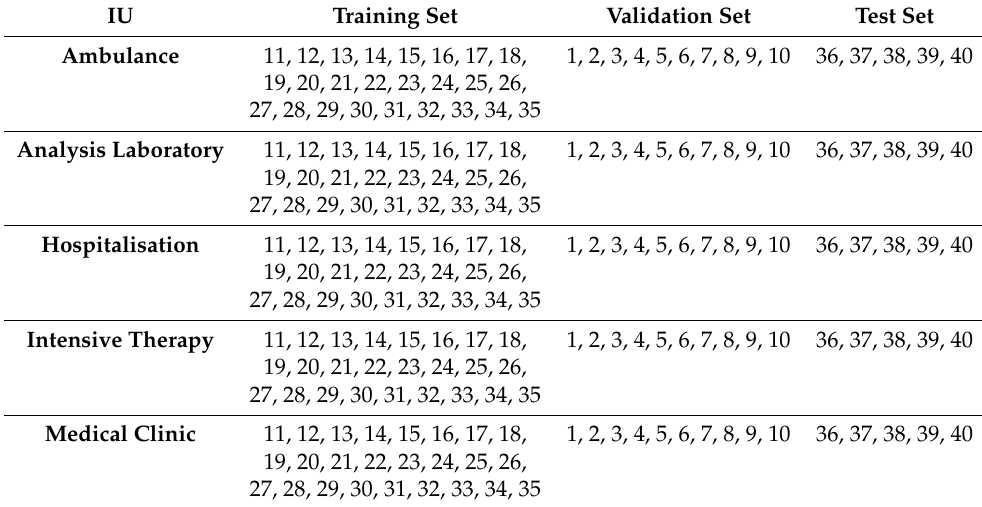
Table 4. Selection of the training set, validation set and test set for the second version of the Detectron2 model (9